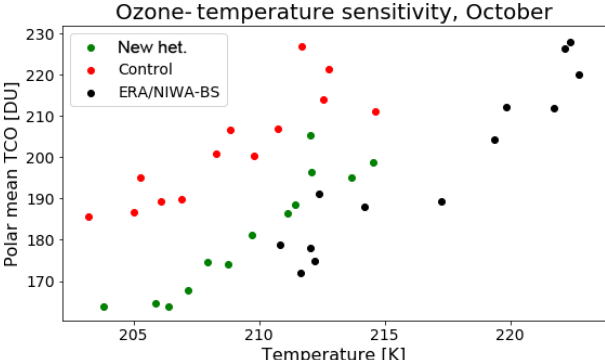
Figure 7. Southern polar mean total column ozone versus the mean temperature in the polar lower stratosphere for the “new het.” (green) and control (red) runs as well as NIWA-BS/ERA-Interim (black). The average is taken over the region south of 65 ◦ S; temper- ature is additionally averaged over the 100–10hPa pressure range. Data cover the years 1996–2009 (excluding